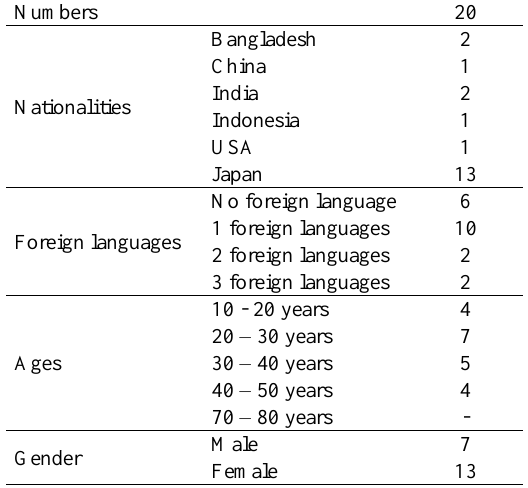
Table 6. Students of the exploratory